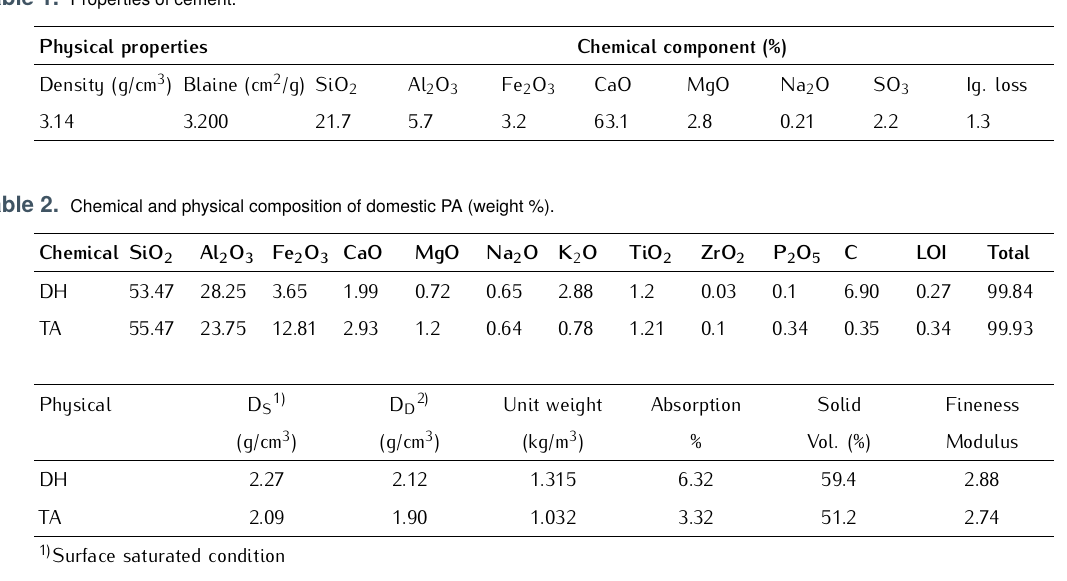
Table 1. Properties of cement.